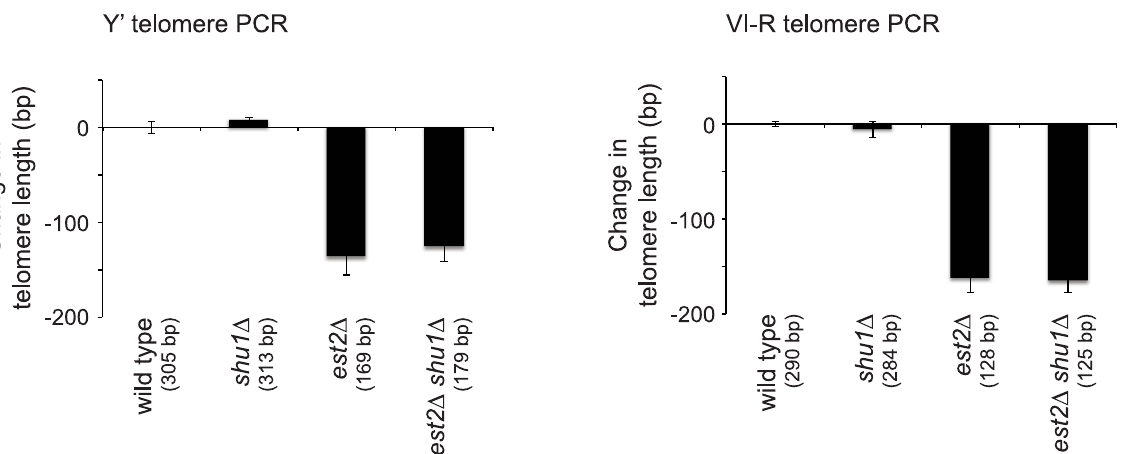
Fig 2. Deletion of SHU1 does not affect telomere length in the presence or absence of telomerase. Strains of the indicated genotypes, generated from the sporulation of an est2 Δ / EST2 shu1 Δ / SHU1 diploid, were assayed for telomere length by Y 0 and VI-R telomere PCR after being passaged for approximately 35 generations. The change in telomere length, compared to wild-type telomere length, was quantified and plotted. Mean ± standard error for 3 – 4 independent isolates for each genotype are shown. Raw mean telomere length values are given in parentheses.